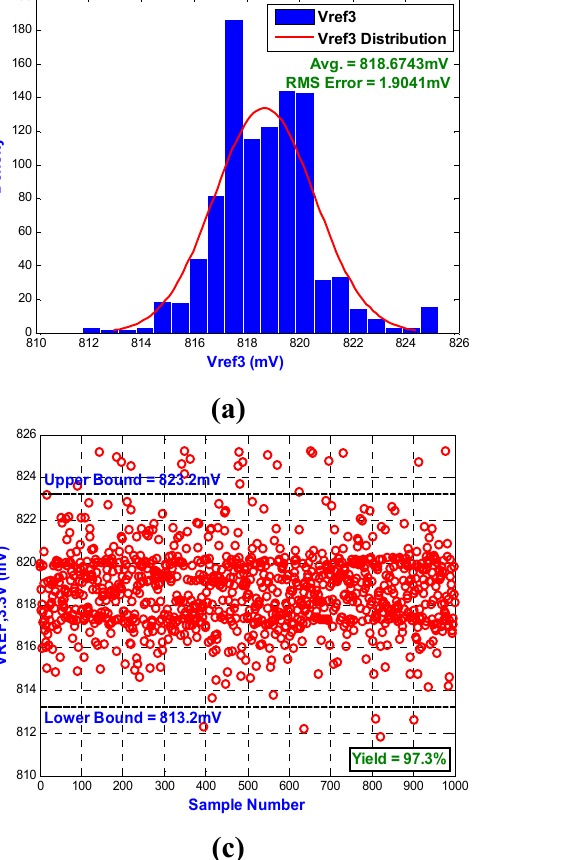
Figure 6. The results of the Monte Carlo analysis for (a) histogram of voltage references, V (b) histogram of voltage references, V REF ,3.3 V V (d) scatterplot of voltage references, V REF ,3.3 V